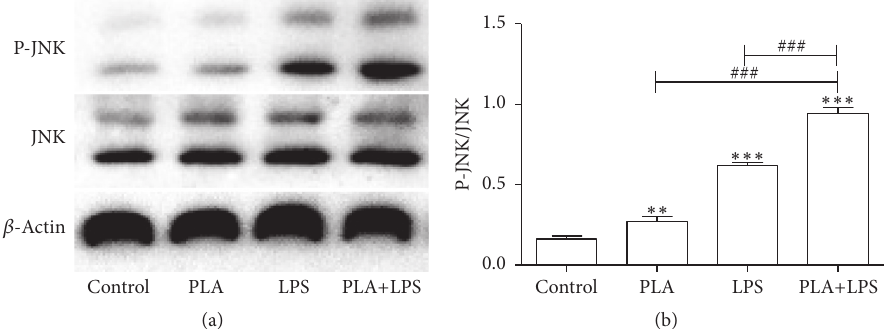
Figure 2: Synergistic effect of PLA+LPS on JNK signaling in NCI-H292 cells. The expression levels of p-JNK and JNK were measured by western blotting in NCI-H292 cells stimulated with 5 𝜇 g/mL PLA, 5 𝜇 g/mL LPS, or 5 𝜇 g/mL PLA + 5 𝜇 g/mL LPS for 60 min; 𝛽 -actin was used as an internal control. The PLA+LPS group showed a further increased level of p-JNK, which was greater than that of LPS or PLA alone. Significant differences are shown as follows: compared with the control group, ∗∗ 𝑃 < 0.01 , ∗∗∗ 𝑃 < 0.001 ; compared with PLA+LPS group, ### 𝑃 < 0.001